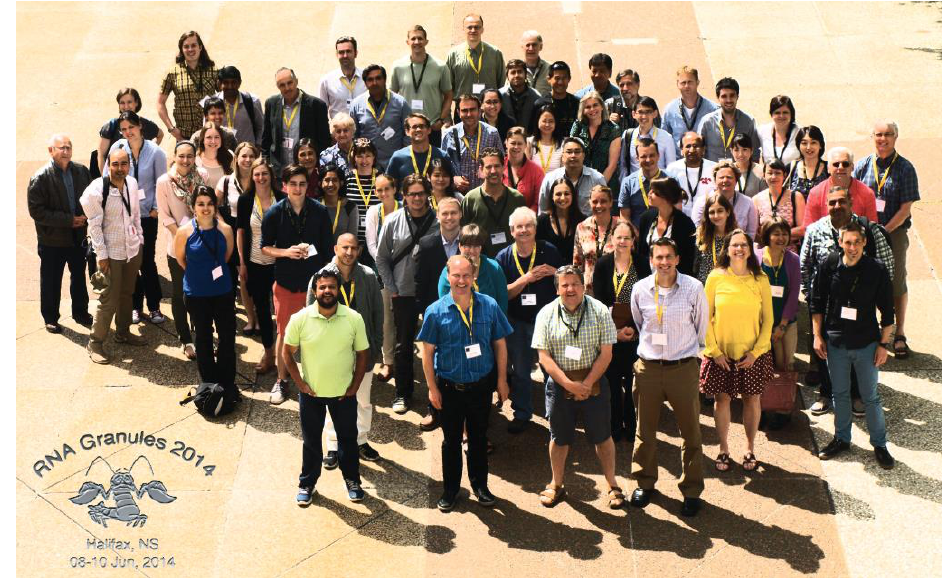
Figure 1. RNA Granules 2014 group